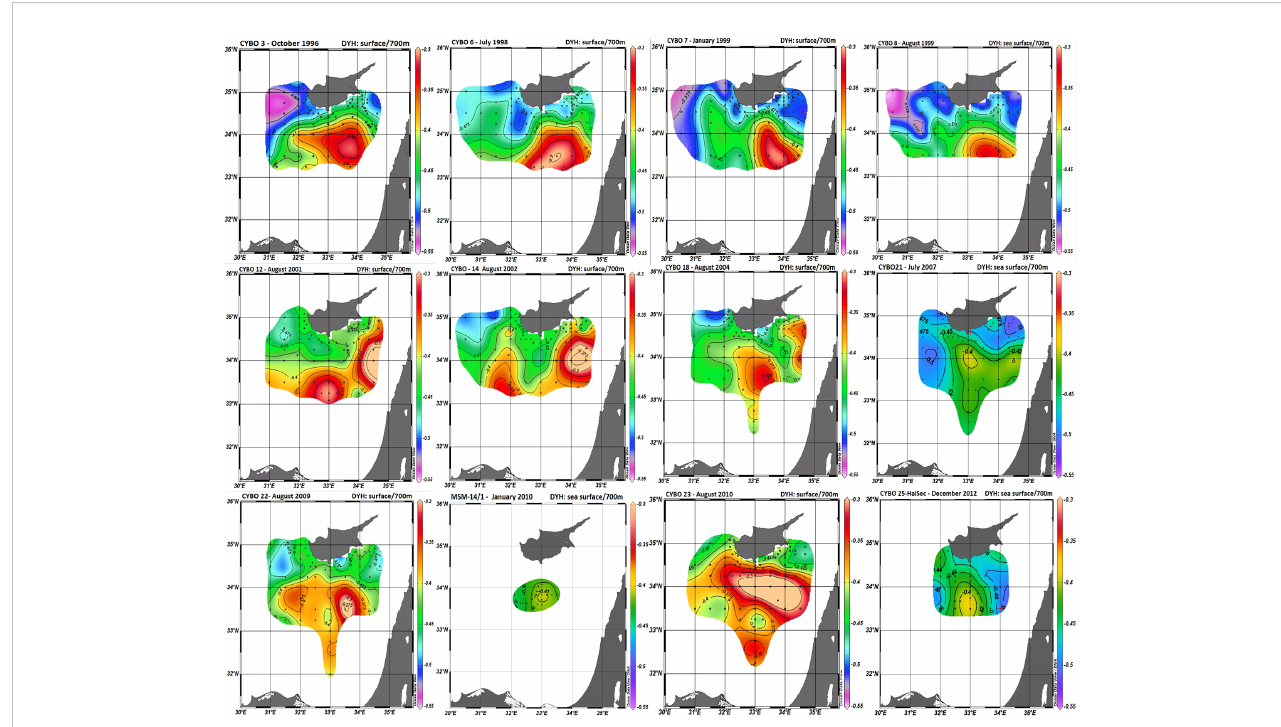
FIGURE 5 The dynamic height topography relative to 700 dbar during the cruises CYBO 3, 6, 7, 8 (top row); CYBO 12, 14, 18, 21 (middle row); and CYBO 22, MSM 14-1, CYBO 23, CYBO-HaiSec 25 (bottom row) corresponding to three active periods with: top row the dominance of the Cyprus Eddy (1996-1999), middle row the co-existence of the Cyprus and Shikmona eddies (2000-2007) and bottom row the dominance of the Cyprus Eddy